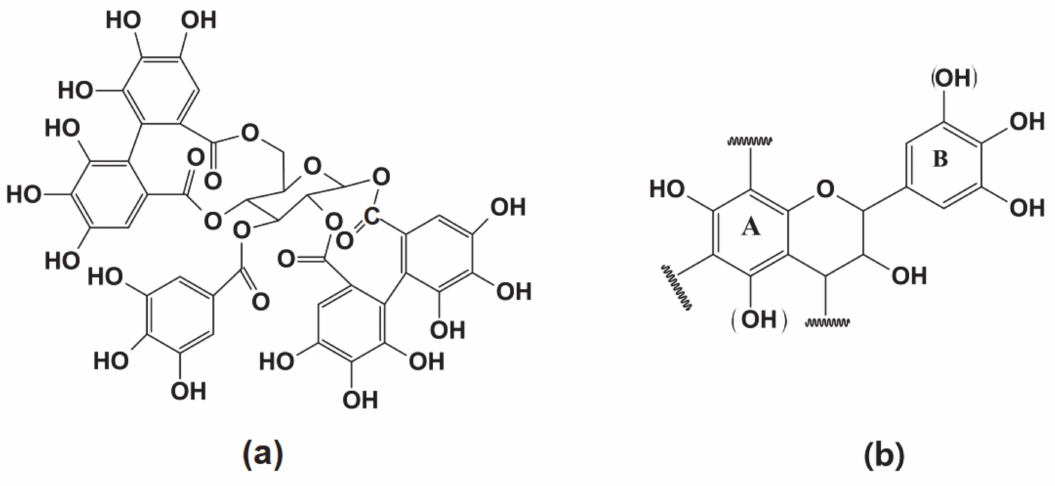
Figure 3. Structures of ( a ) hydrolysable tannins and ( b ) condensed (flavonoid)